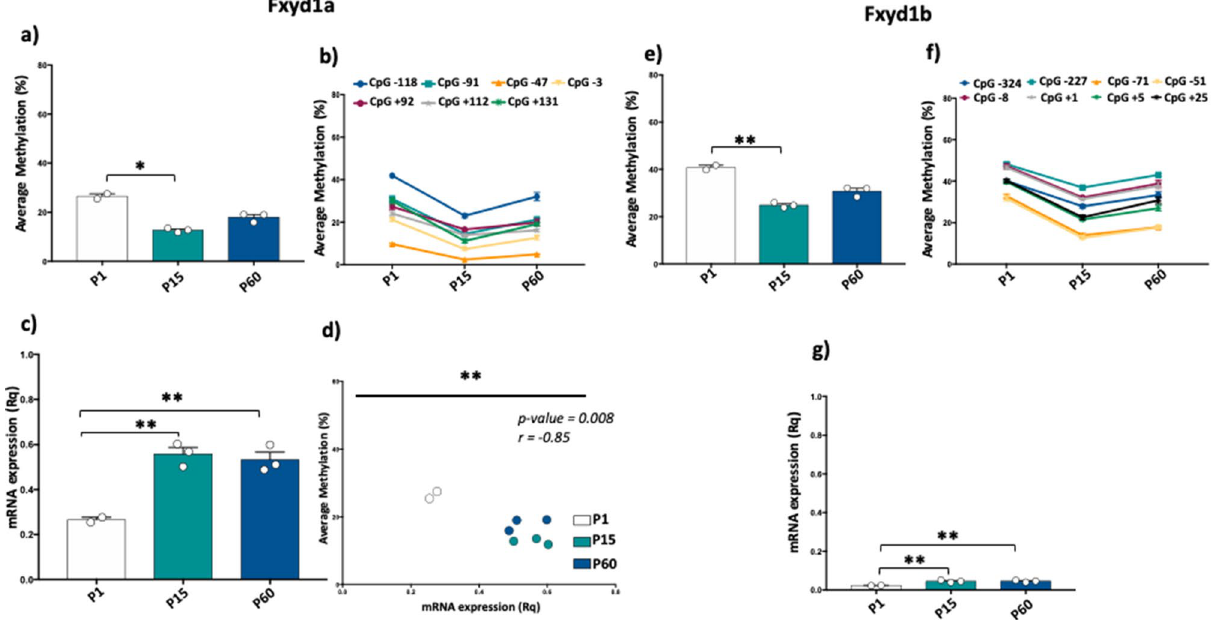
Figure 3. DNA methylation and mRNA expression of the Fxyd1a and Fxyd1b genes in the heart. ( a ) Fxyd1a average methylation (%) at P1, P15 and P60 developmental stages. Comparisons between developmental stages were performed using One-way ANOVA followed by Multiple t test. ( b ) Average methylation at all analyzed CpG sites at Fxyd1a promoter during heart development. ( c ) mRNA expression levels of Fxyd1a at all